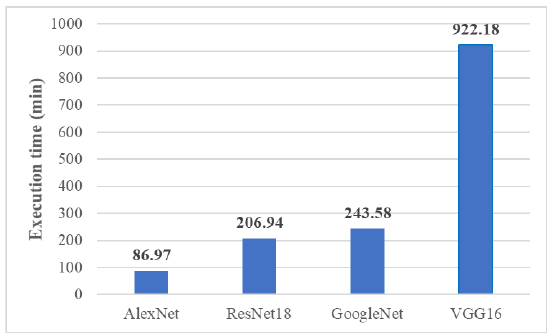
Figure 5. Comparative elapsed training time results.